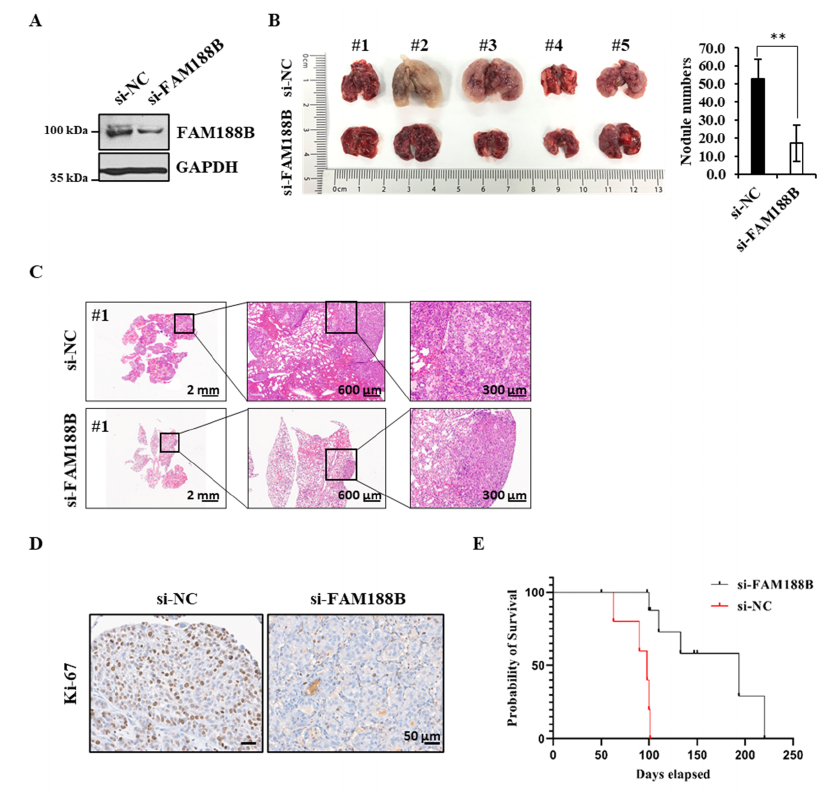
Figure 5. In vivo effects of FAM188B knockdown on lung metastasis and survival in xenograft mouse model. ( A – E ) A549 cells were transiently transfected with either si-NC or si-FAM188B for 48 h, and then cells were injected to BALB/c nude mice ( n = 10) via the tail vein. FAM188B knockdown in A549 cells was verified by immunoblotting and the levels of FAM188B were quantified by densitome- try and normalized to GAPDH (Figure S4C) ( A ). The mice were sacrificed after eight weeks, lung images were shown (left panel), and the number of tumor nodules in the lungs was counted (right panel) ( B ). Representative pictures of hematoxylin and eosin staining of lung tissues were shown. Scale bars = 2 mm, 600 µ m, and 300 µ m ( C ). Lung tissues were processed for immunohistochemistry with anti-Ki-67 antibodies. Scale bars = 50 µ m ( D ) Kaplan–Meier survival curves of mice bearing either si-NC-A549 cells or si-FAM188B-A549 cells ( E ). (** p < 0.01, versus si-NC) Similar results were observed in two independent